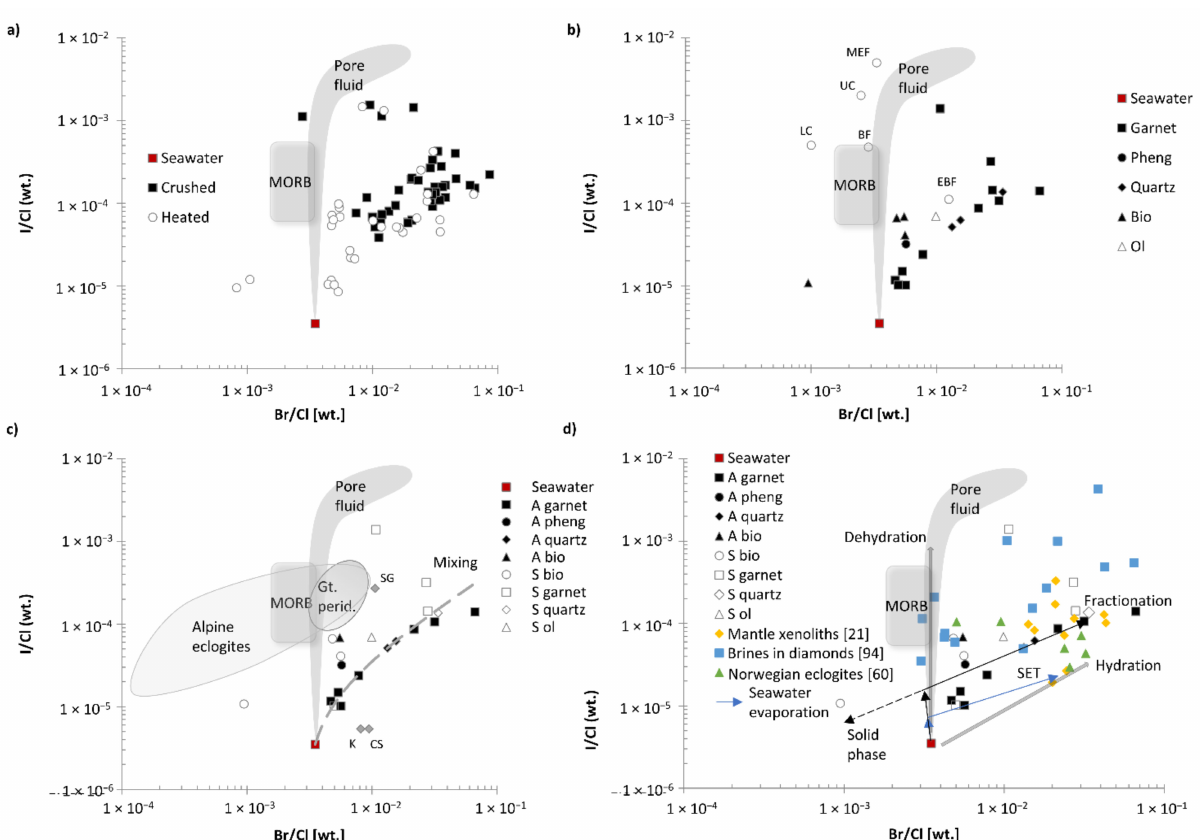
Figure 8. I/Cl vs. Br/Cl ratios of WGR samples. ( a ) Crushing vs. heating compared to MORB, seawater and pore fluid fields. ( b ) Mineral type compared to MORB, seawater, pore fluid, Monviso eclogite fluids (MEF), upper crust (UC), lower crust (LC), sedimentary basin fluids (BF) and evaporite-bearing fluids (EBF). ( c ) Mineral phase and area compared to fields of MORB, marine pore fluid, Alpine eclogites, garnet peridotites, the seawater halogen composition and the composition of crustal basement fluids from the Stripa granite (SG), the Keeweenaw peninsula (K) and the Canadian shield (CS). The dotted line represents a mixing trend, according to the mixing equation in [95], between seawater and an unknown Br- and I-rich endmember, and shows that many of the samples in this study lie along or close to the mixing trend, ( d ) Mineral type and area compared to MORB, seawater, pore fluid, Norwegian eclogites [60], brines in diamonds [94] and Siberian xenoliths [21] from the sub-continental lithospheric mantle. Additionally, shown in ( d ) are a fractionation trend through preferential Cl removal and a seawater evaporation trend (SET), along with the evolution of halogen ratios through metamorphic processes such as dehydration and hydration reactions [60]. MORB field is from [8,12,88]; Seawater is from [89]. Pore fluids are from [90–93]. MEF is from [96], UC and LC are from [97], BF is from [98], EBF is from [60], the Stripa granite is from [99], the Keeweenaw peninsula is from [100] and the Canadian shield is from